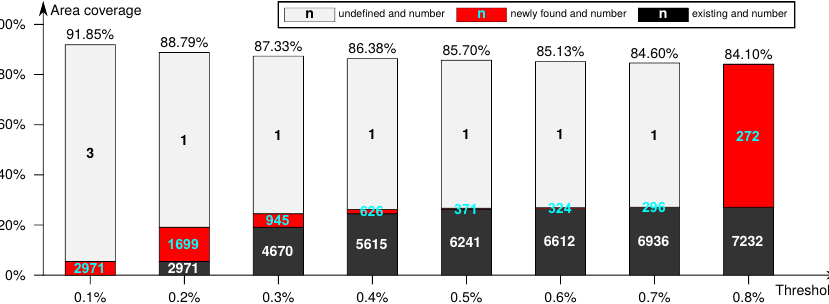
Figure 10. Area coverage and number of changes of regions of the Wuhan data in the iterative extracting process.